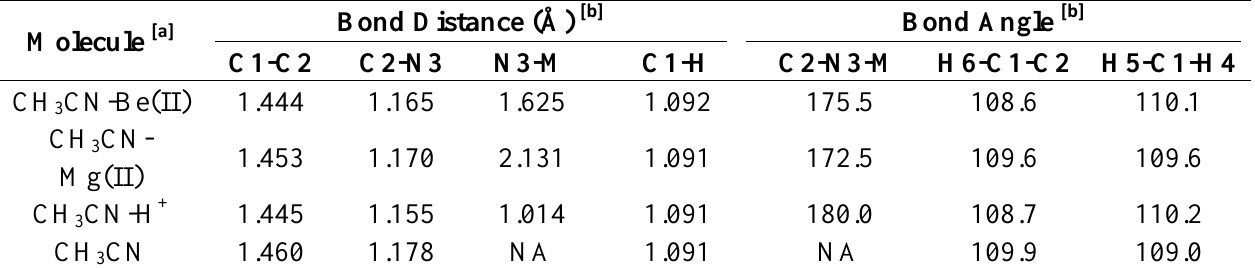
Table 4. Bond distances of acetonitrile and its complexes with Be(II), Mg(II) and H + .